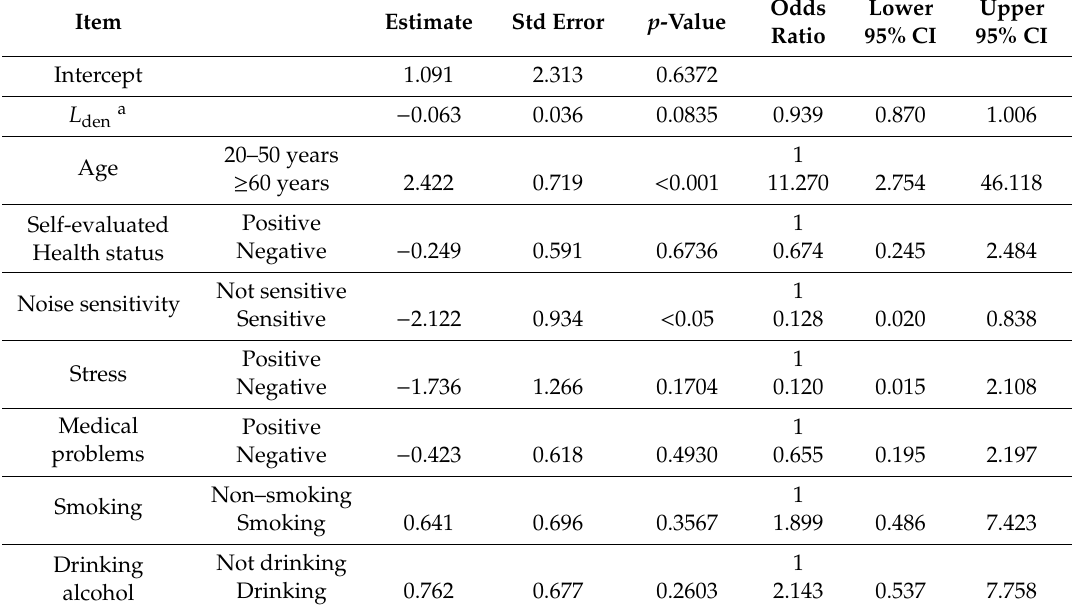
Table 11. The results of multiple logistic regression analysis for investigating the relationship between noise level and high blood